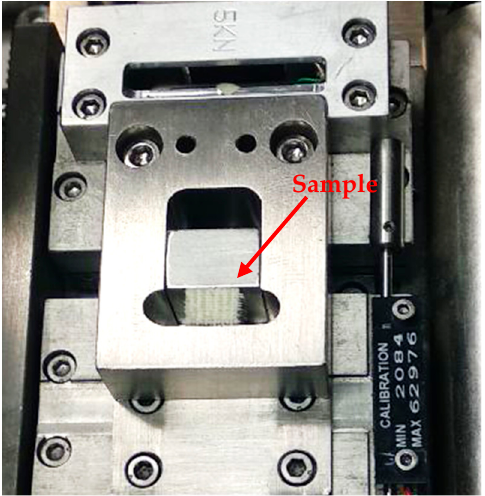
Figure 9. Test configuration as well as sample placement within the in-situ compression test device.